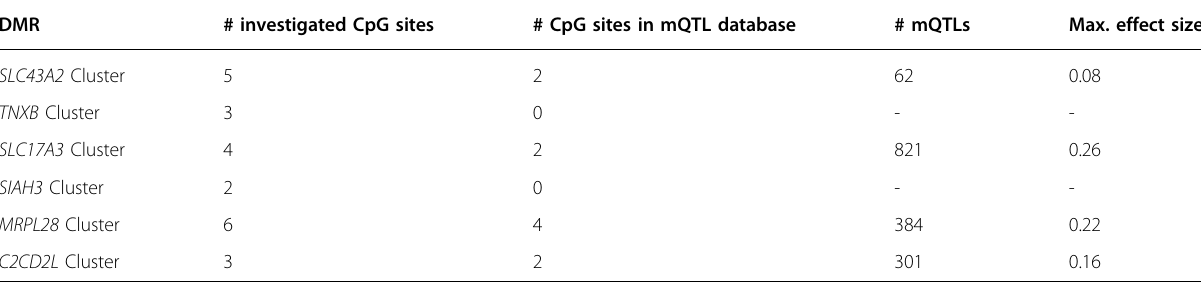
Table 2 Number of mQTLs in fl uencing DNAm in each DMR. DMR # investigated CpG sites # CpG sites in mQTL database # mQTLs